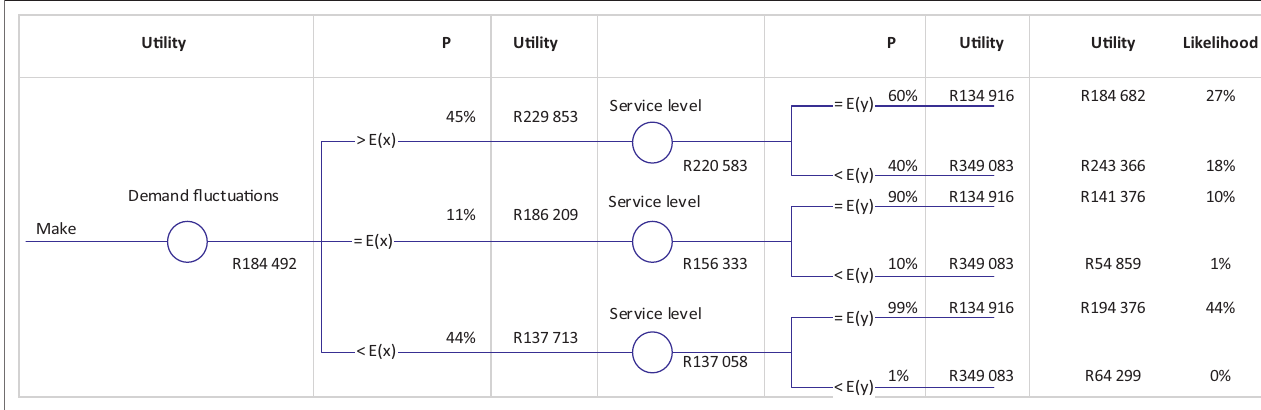
FIGURE 4: Service level